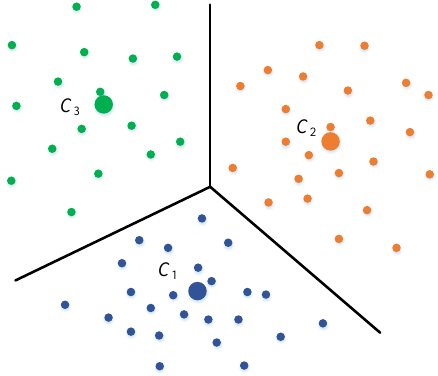
Figure 5. K-means clustering process used to group nearby training points into separated clusters, and position targets transformed from coordinates into labels.